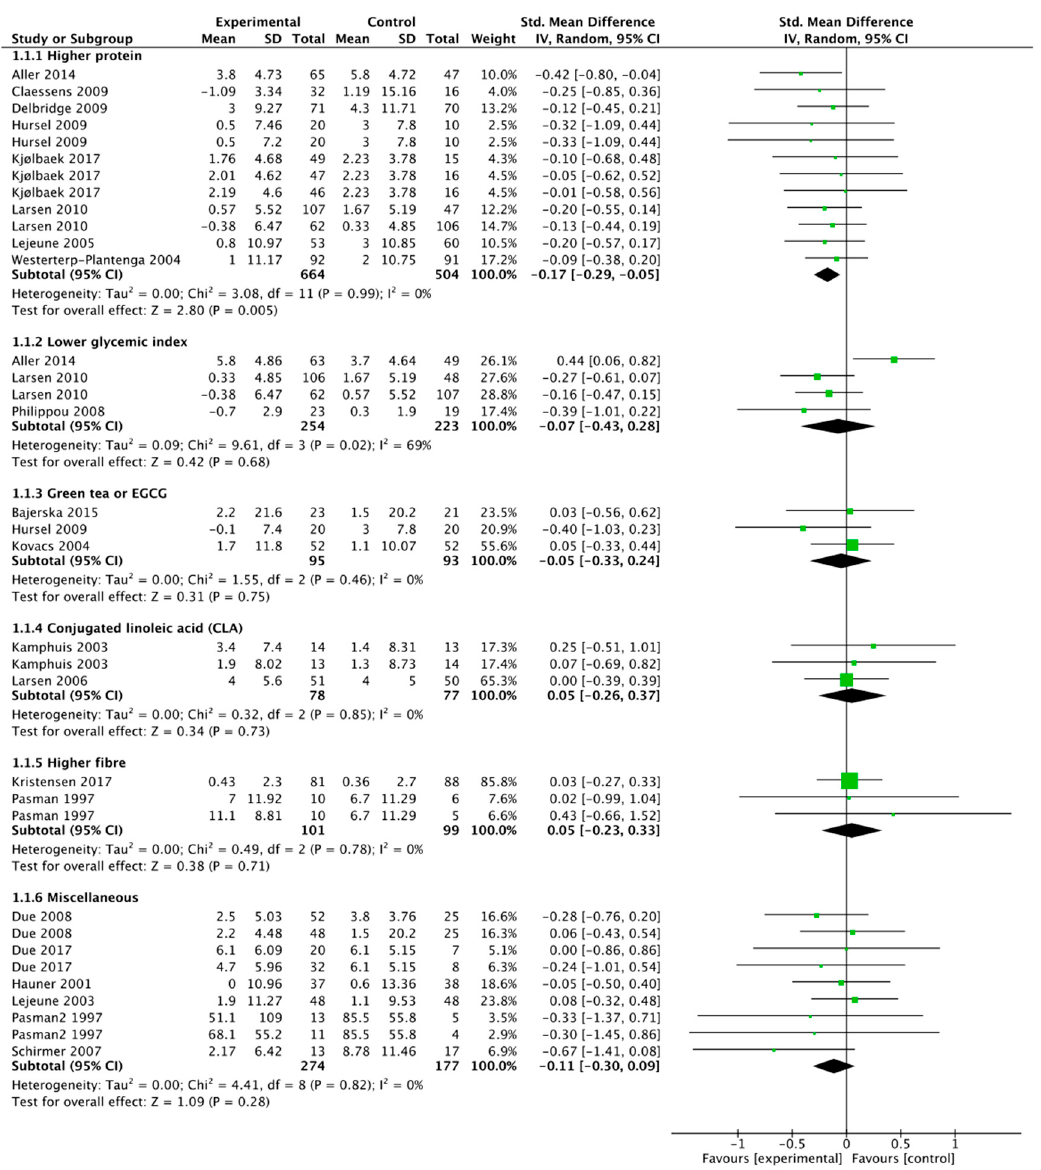
Figure 1. Forest plots of dietary strategies for the prevention of weight regain after weight loss. The box size is proportional to the weight contributed by the study to the combined study mean. Horizontal lines span individual study 95% confidence intervals (CI). Diamonds represent the combined study standardized mean value and the corresponding 95% CI values.